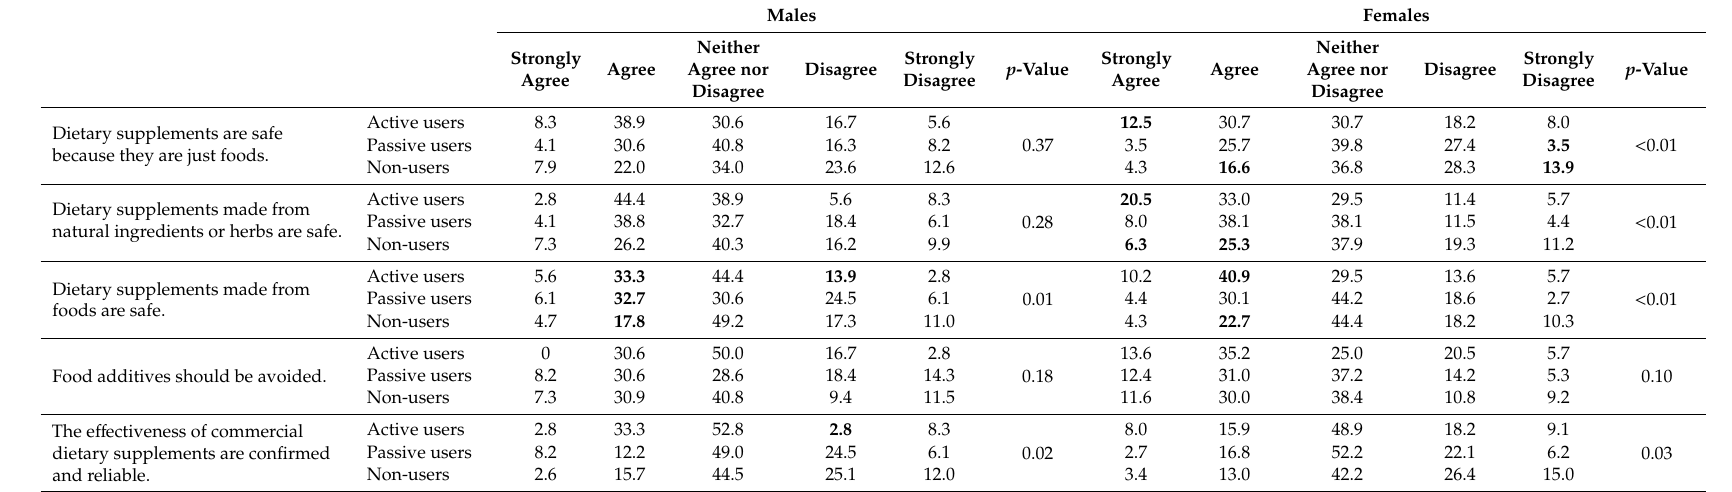
Table 2. Perceptions of dietary supplements according to sex and the use of dietary supplements (% of